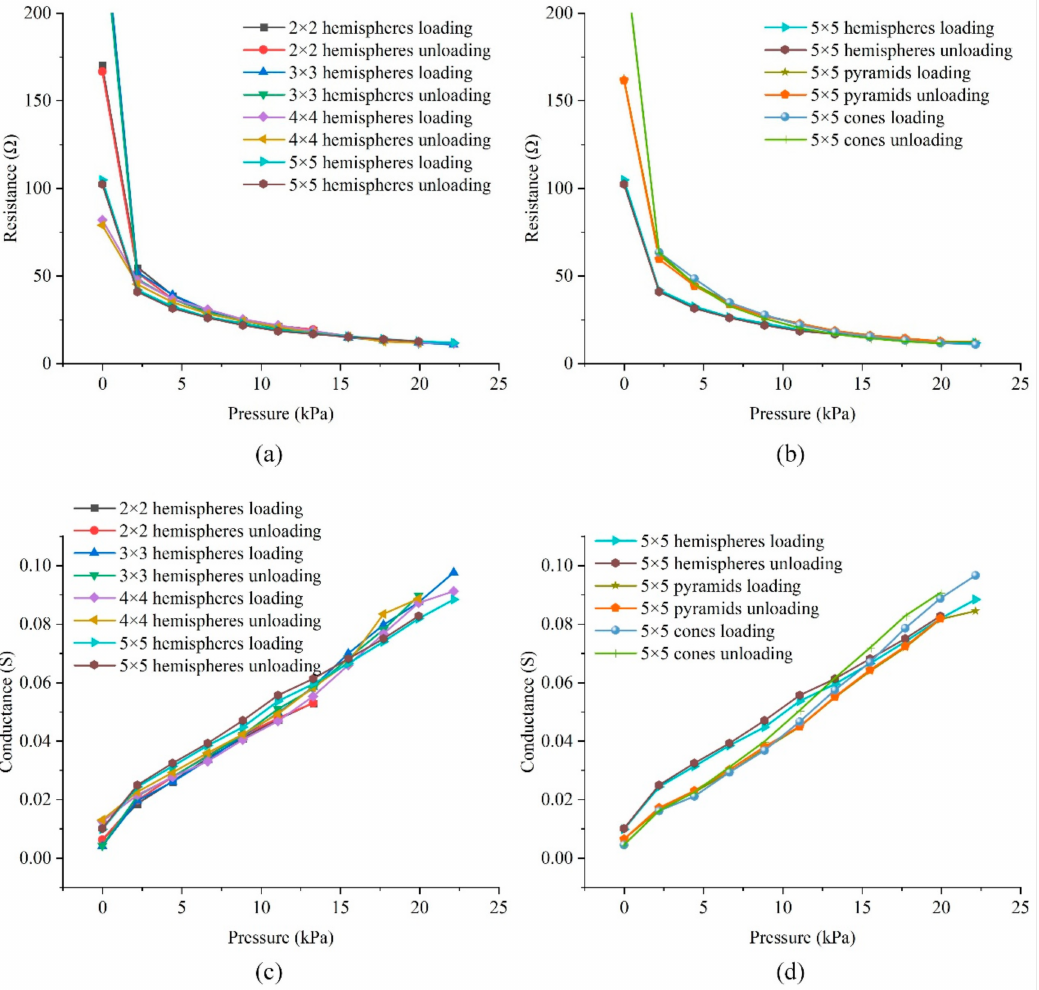
Figure 9. Sensors static test results: ( a , c ) Sensors with different hemispheres distribution densities; ( b , d ) Sensors with different